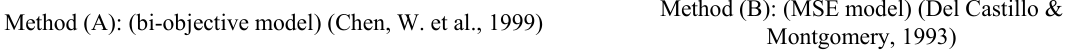
Two methods of optimization based on dual response